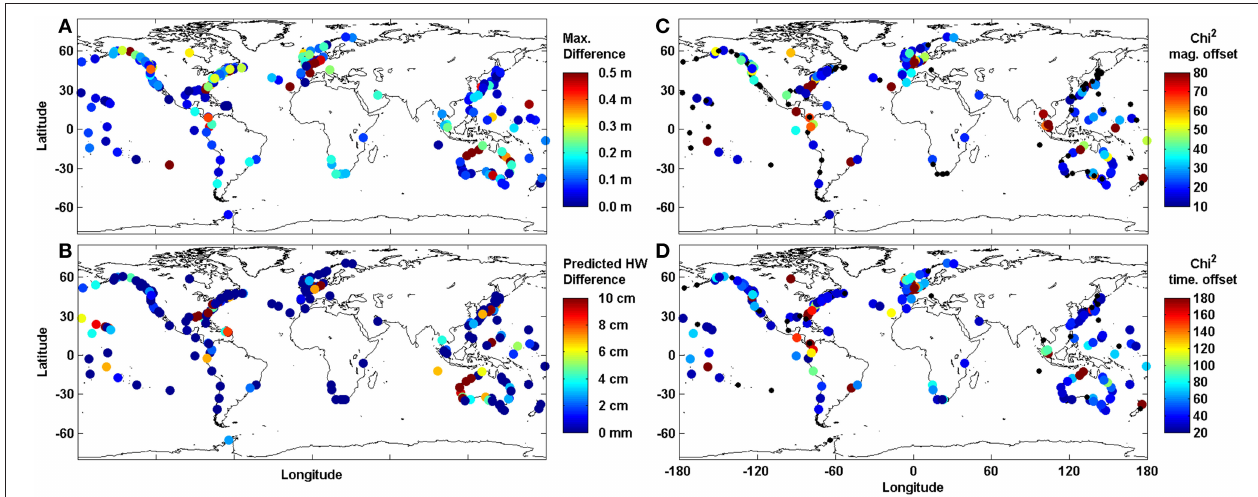
FIGURE 3 | Global maps of the 220 selected sites. (A) difference between the maximum NTR and the maximum skew surge value. (B) difference between the maximum skew surge value and the maximum NTR occurring at the same time as predicted HW (C) χ 2 values showing magnitude of tide at time of peak NTR for the 200 largest NTR. (D) χ 2 values showing time of peak NTR relative to predicted HW for the 200 largest NTR event. Black dots (C,D) show non-significant values in the chi-squared test (based on p -values larger than 0.05).